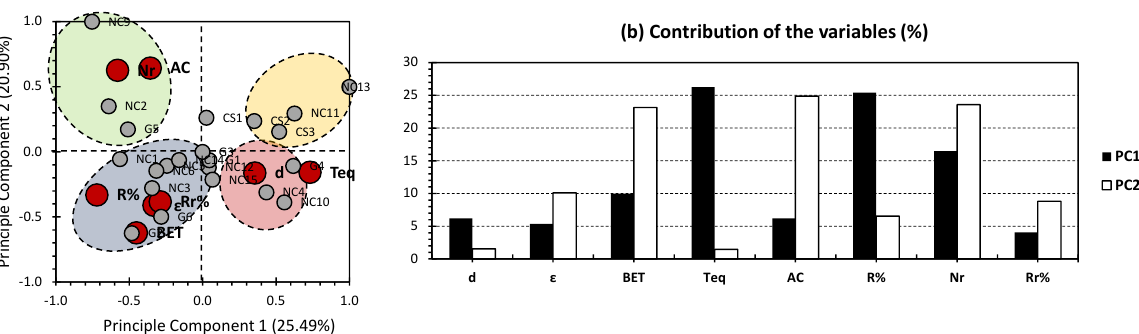
Figure 2. PCA-biplot for all datasets, with the exclusion of NC7 and NC8. Grey bullets represent the individuals of the population (different investigated nanocellulose-based aerogels). Red bullets represent the variables (different employed physical/chemical and adsorption parameters). The yellow cluster gathered the chitosan-based aerogels (CS1, CS2, and CS3); the blue cluster gathered nanocellulose-based aerogels NC1, NC3, NC5, NC6, and NC14 and graphene-based aerogels G2, G3, and G6; the green cluster gathered aerogels NC2, NC9, and G5; the red cluster gathered nanocellulose- based aerogels NC4, NC10, NC12, and NC15 and graphene-based aerogels G1, and G4. For the individuals, four different clusters can be distinguished: upper right (yellow), upper left (green), lower left (blue), and lower right (red) (Figure 2). The yellow